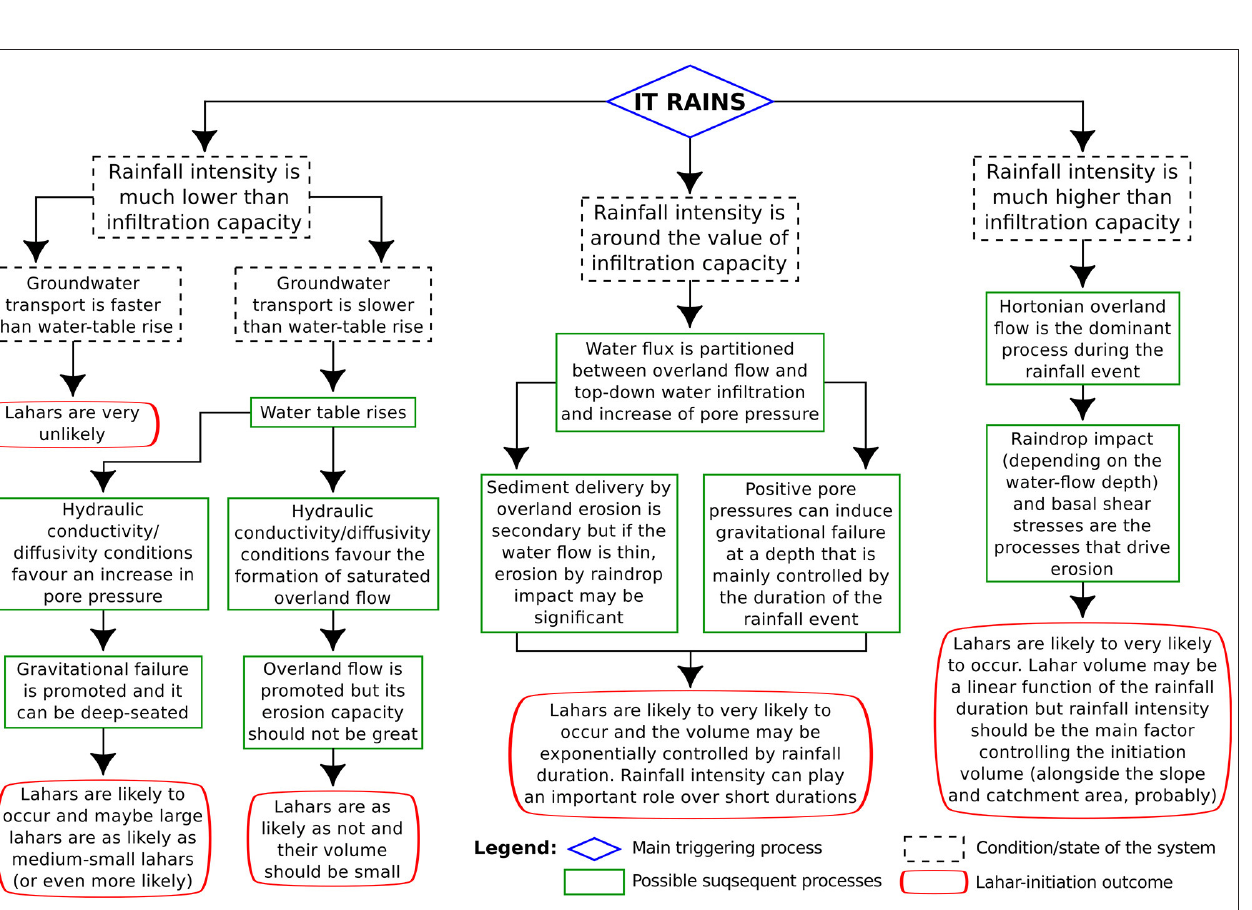
Frontiers in Earth Science |